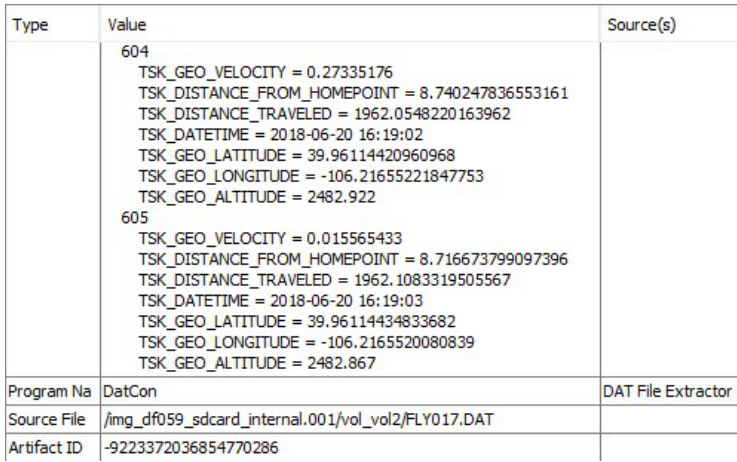
Figure 2. Highlighting the date issue on the parsed flight log by Autopsy.